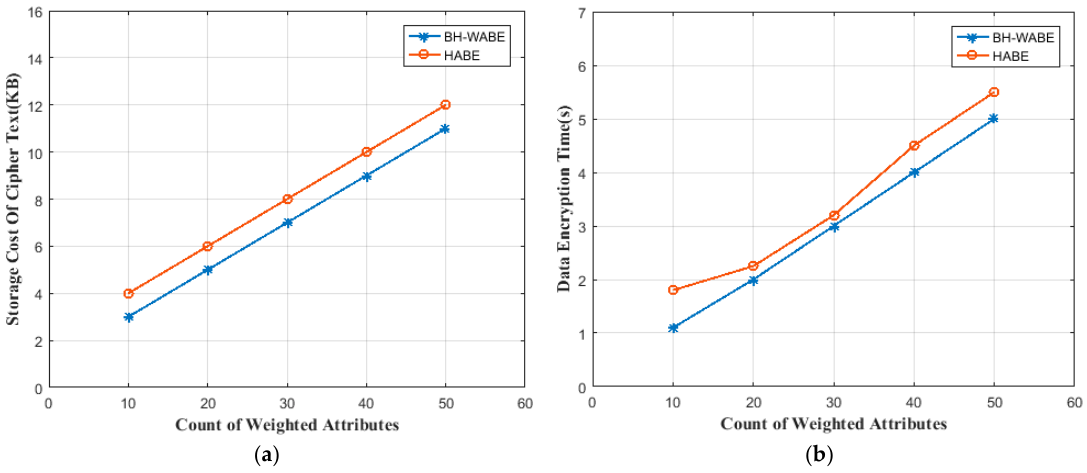
Figure 9. Cost of cipher text. ( a ) Storage cost analysis; ( b ) Time cost analysis